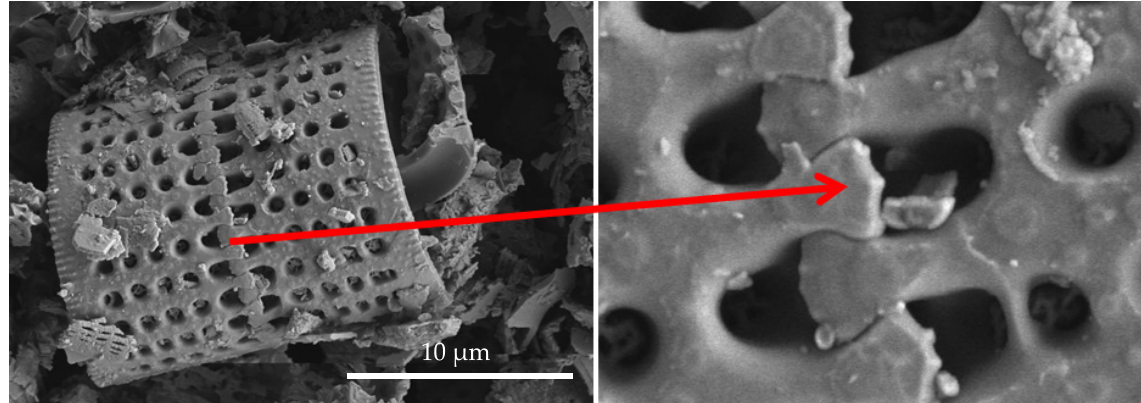
Figure 3. The “zipper” mechanism for creating colonies.